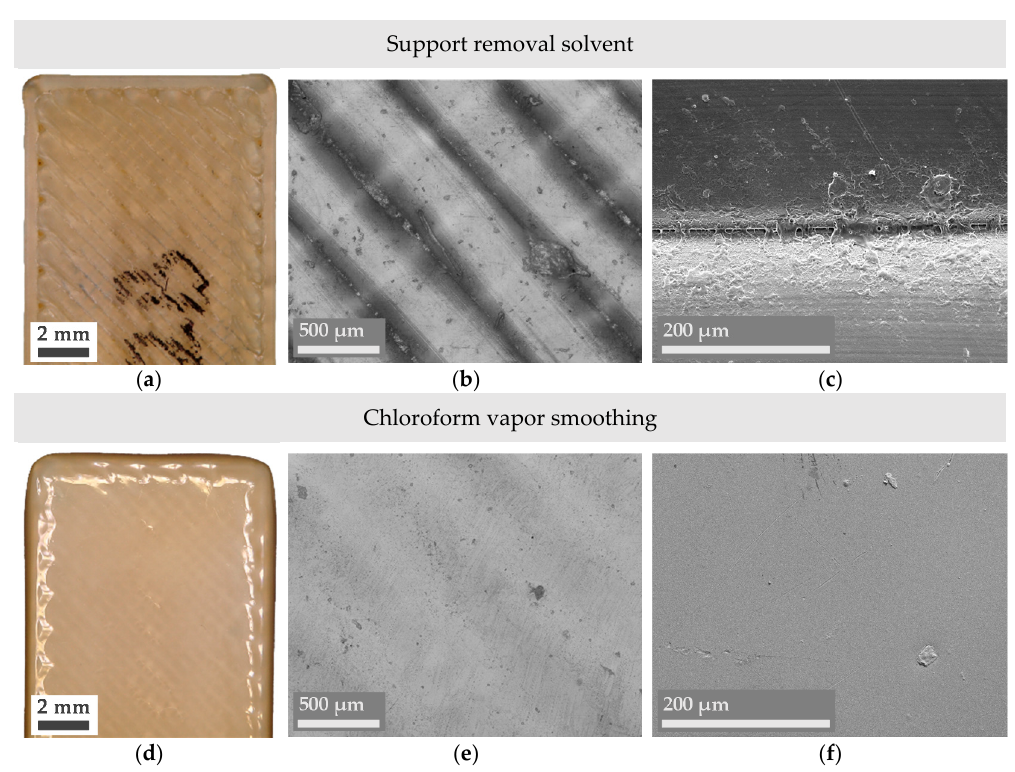
Figure 3. Digital microscope ( a , b , d , e ) and SEM micrographs ( c , f ) of the chemically treated Ultem parts. 364